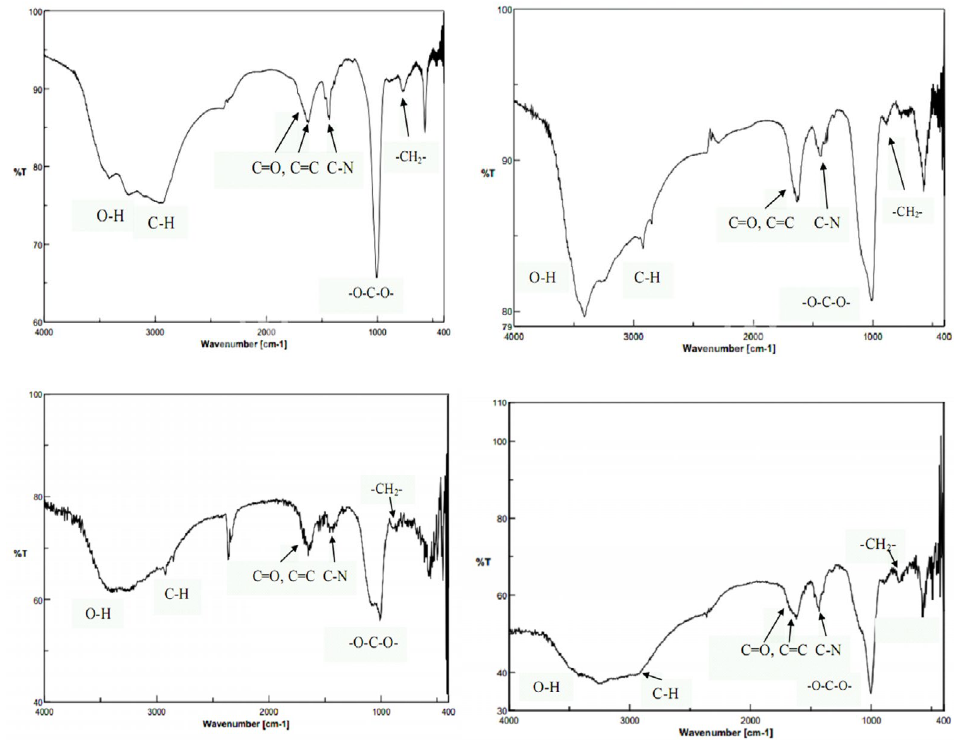
Fig. 4. FT-IR results of the Ag nanostructures prepared at different conditions: (A) 90 W, (B) 270 W, (C) 450 W irradiation power, (D) maceration.